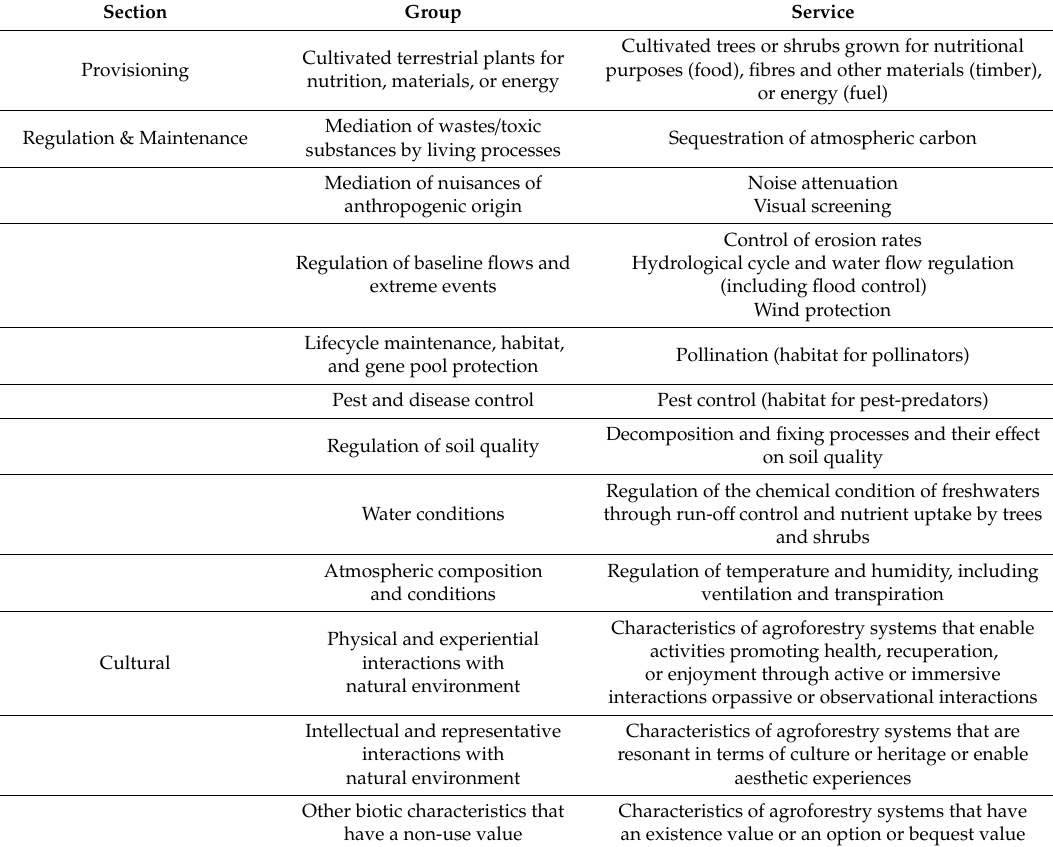
Table 1. Farm-scale ecosystem services provided by agroforestry assets (adapted from CICES V5.1). Section Group